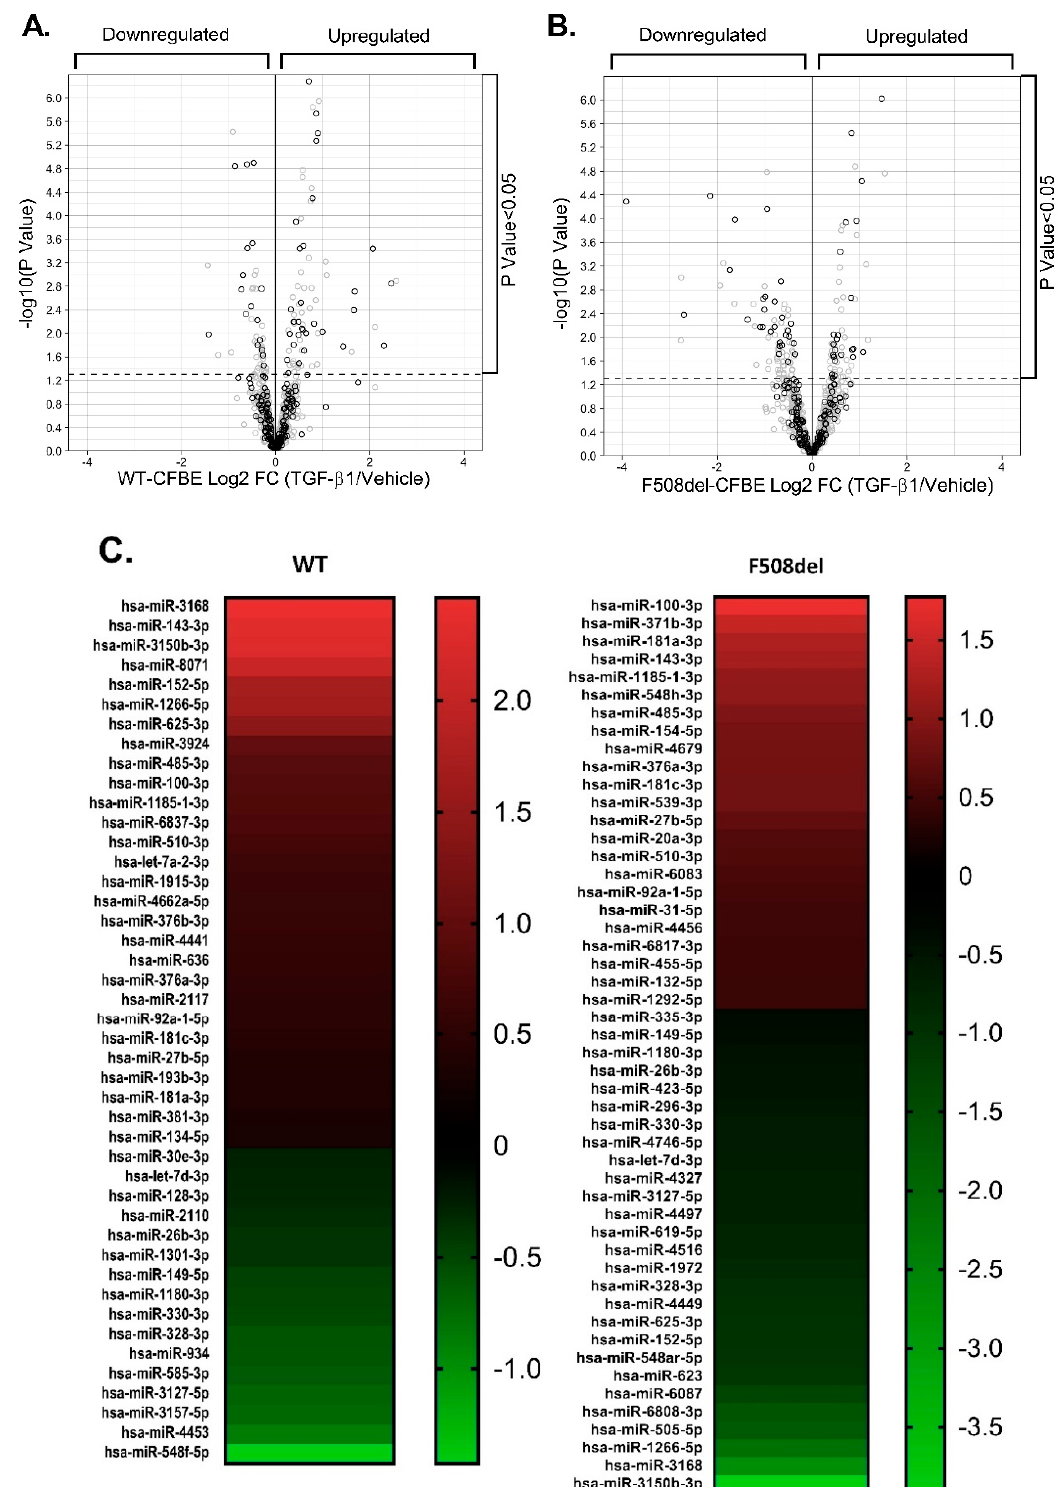
Figure 8. Small RNA-seq data showing effects of TGF- β 1 on the miRNA landscape. Volcano plots of data from WT-CFBE ( A ) and F508del-CFBE ( B ) cells. TGF- β 1 changed expression of many miRNAs predicted to target (black circles) and those not predicted to target (grey circles) the human CFTR 3’UTR. Cells were treated with TGF- β 1 or vehicle for 24 h. The − log10 ( p value) > 1.3 corresponding to p < 0.05 was considered significant. Only shown in Table S1, due to the limitation of volcano plot cut-off area, are hsa-miR-143-3p significantly upregulated in WT- and F508del-CFBE cells with − log10 ( p value) =